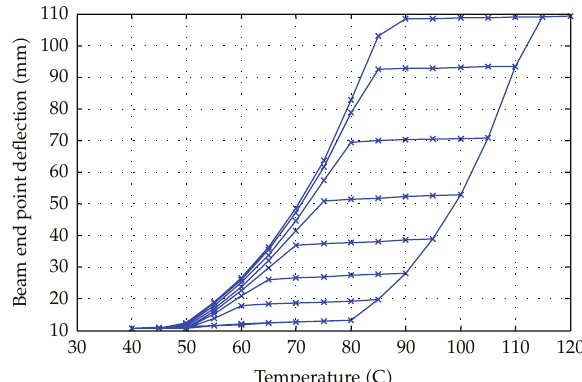
Figure 14: Hysteresis behavior between the beam end point deflection and the SMA wire temperature in the training process.